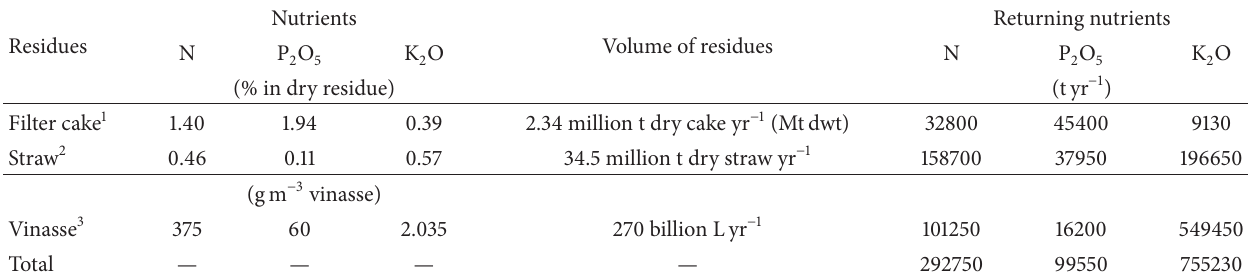
Table 1: Estimates of the potential contribution of byproducts produced by the sugar-alcohol agroindustry to the annual recycling of mineral elements in agriculture (adapted from [33]).